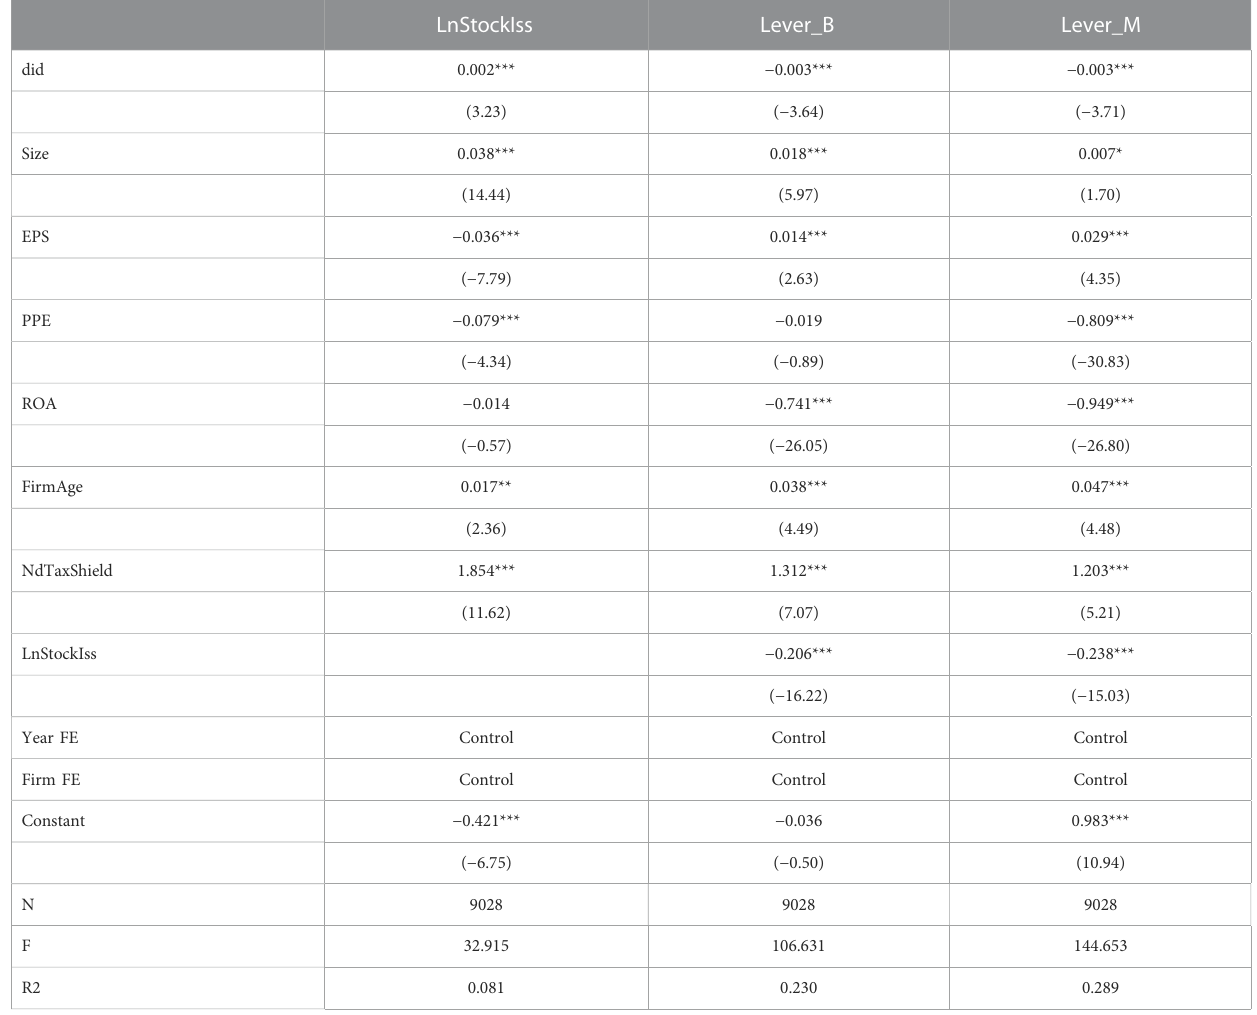
TABLE 9 Carbon trading, equity issuance and capital